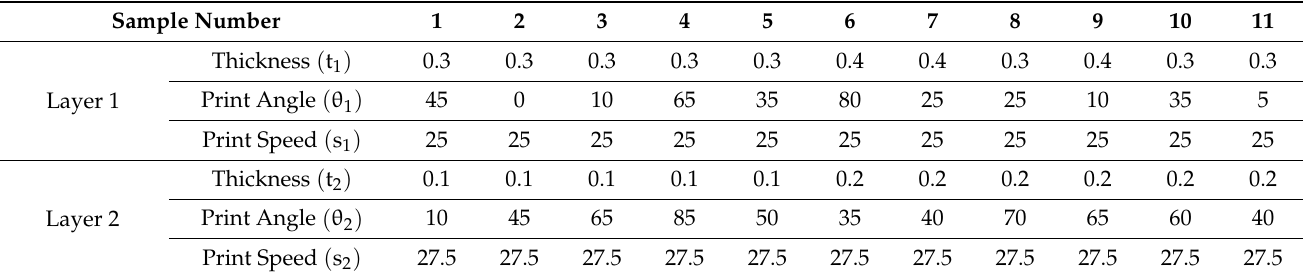
Figure 5. Morphing Bending Angle Prediction and Experimental Deviation. Table 3. Experimental Validation Samples Parameters.